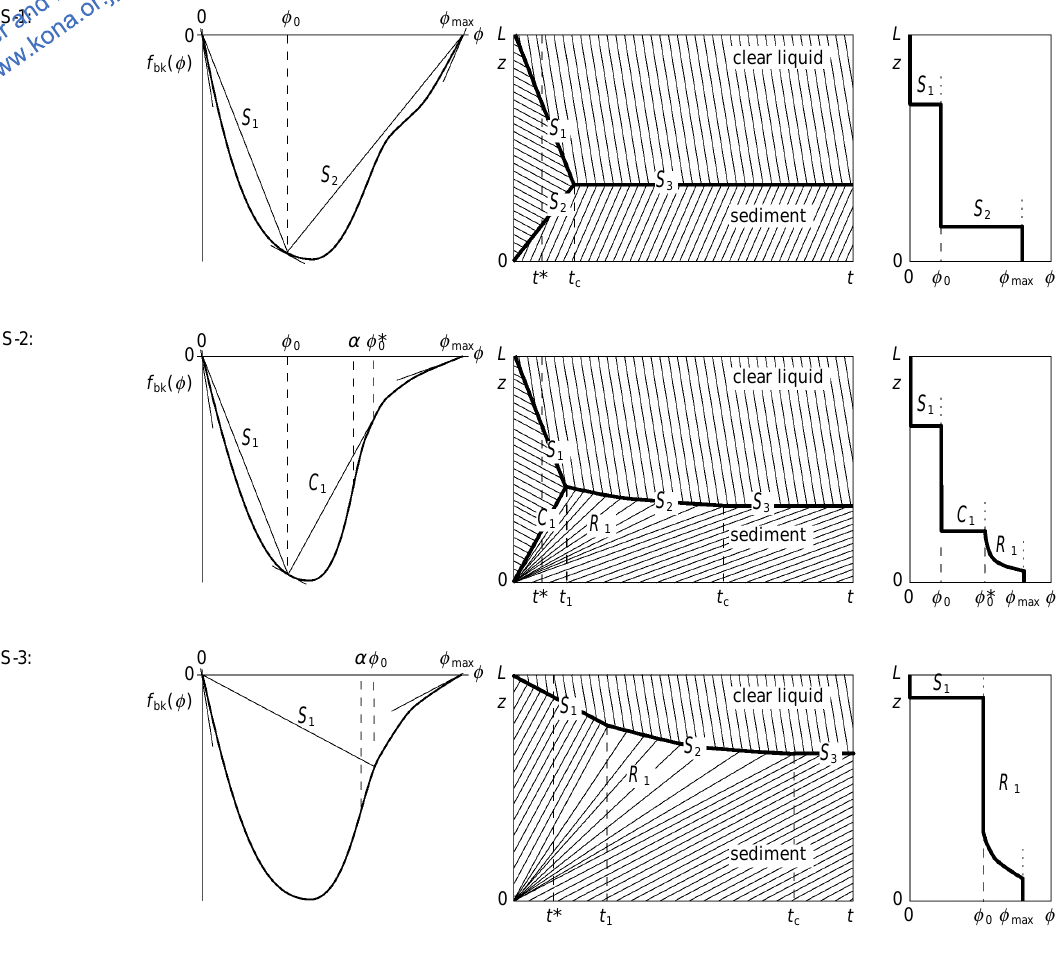
Fig. 6 Modes of sedimentation MS-1 to MS-3. From the left to the right, the flux plot, the settling plot showing characteristics and shock lines, and a representative concentration profile taken at time t (cid:2) t * are shown for each mode. Chords in the flux plots and shocks in the set- tling plots having the same slopes are marked by the same symbols. Slopes of tangents to the flux plots occurring as slopes of charac- teristics in the settling plots are also indicated (Bürger and